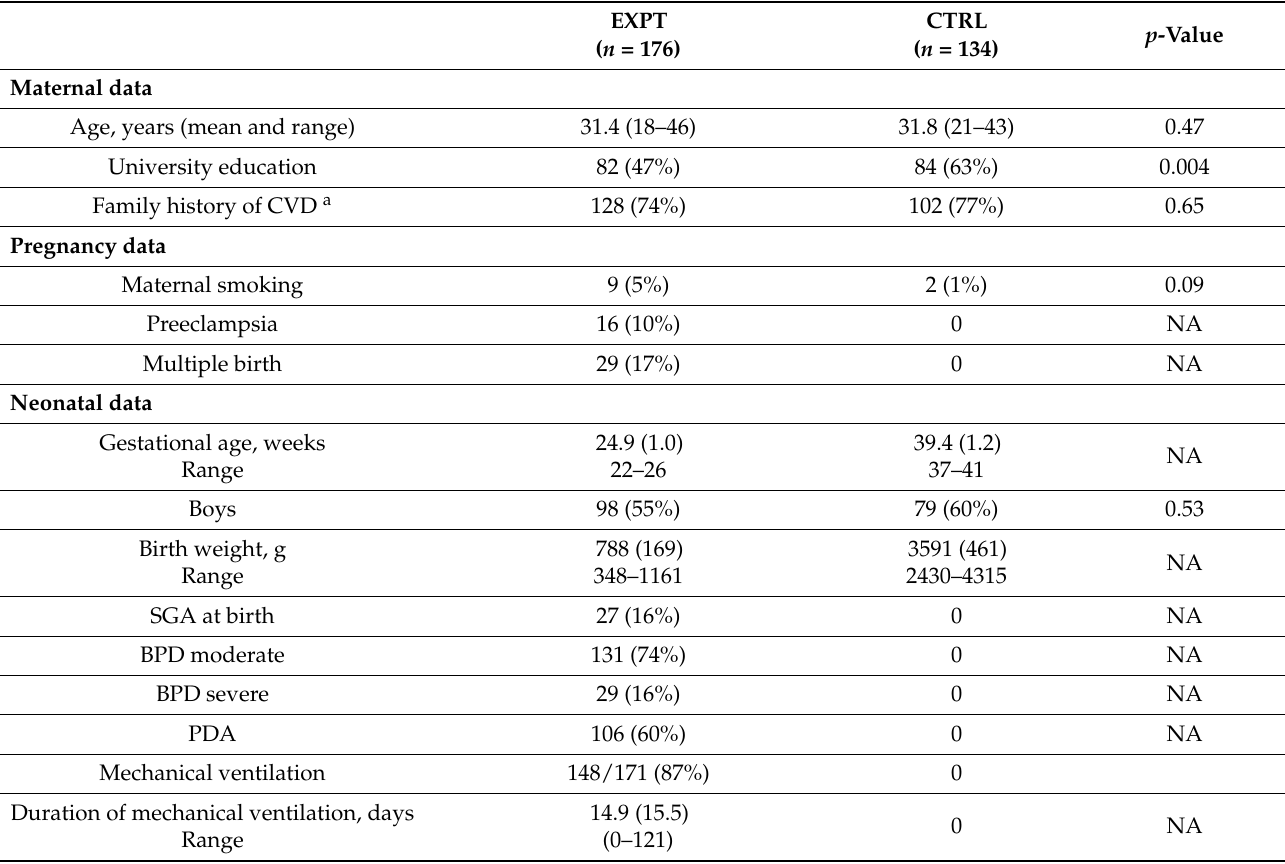
Table 1. Characteristics of 6.5-year-old children born extremely preterm (EXPT) and in controls born at term